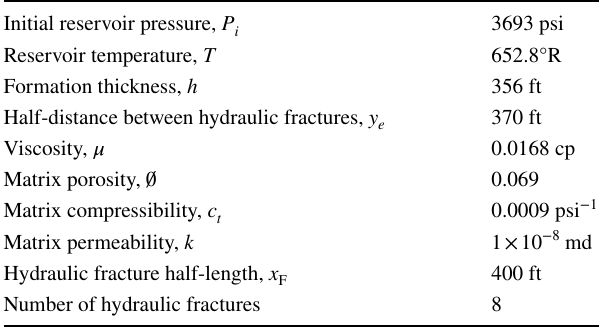
Table 1 Data of the Barnett shale well used in the application,